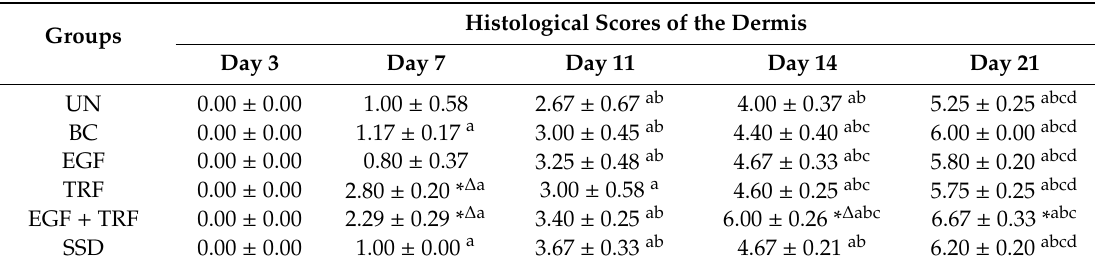
Table 4. Histological scores of the dermis in all the groups over time